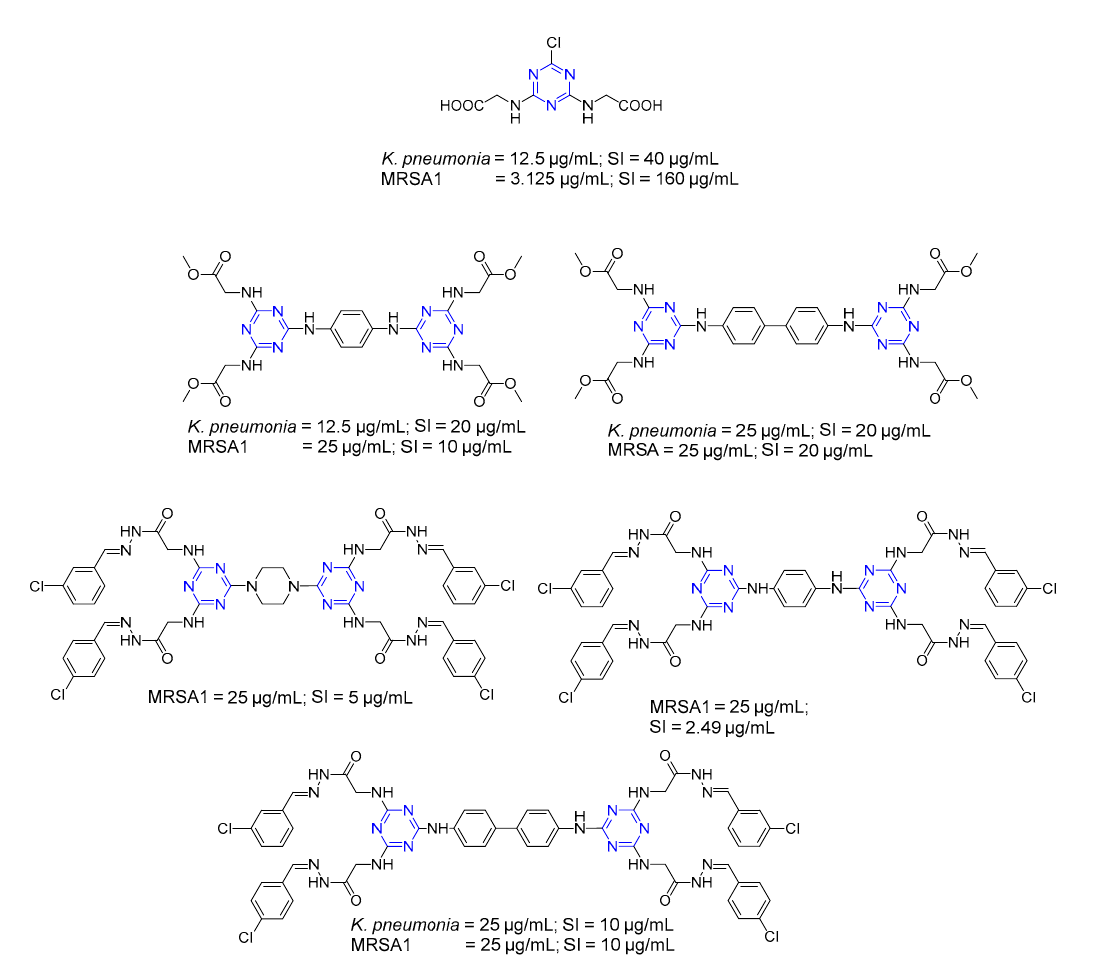
Figure 6. Minimum Inhibitory Concentration (MIC) and selectivity index (SI) of compounds showing activity against K. pneumonia and MRSA1.